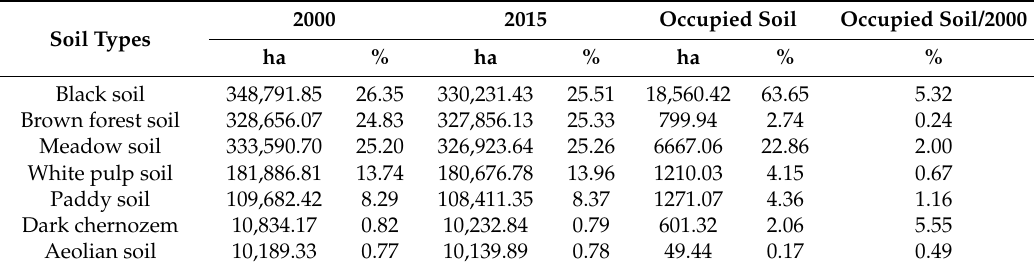
Table 7. Soil area in 2000 and 2015.